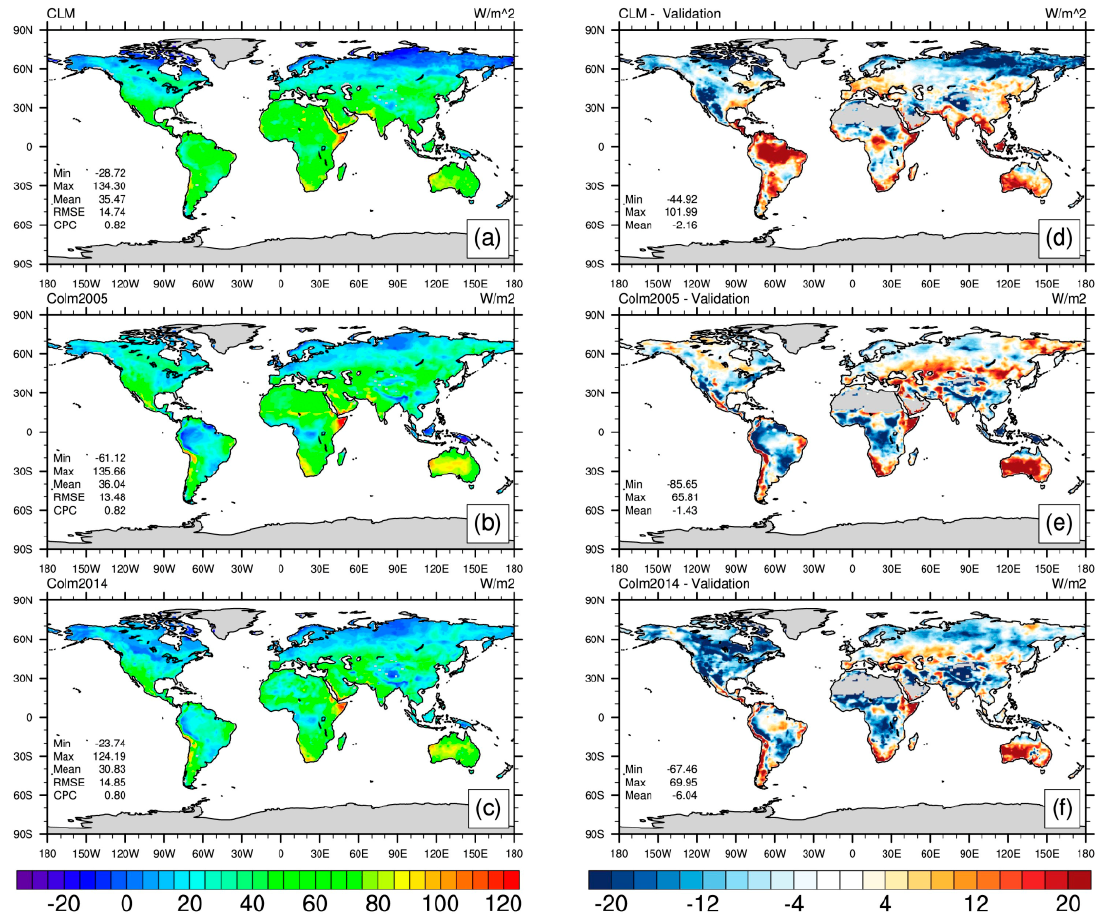
Figure 12. Annual mean spatial distributions of sensible heat flux simulated by ( a ) CLM4.5; ( b ) CoLM2005; and ( c ) CoLM2014; Along with spatial distributions of biases relative to the validation standard for ( d ) CLM4.5; ( e ) CoLM2005; and ( f ) CoLM2014 (Units: W m − 2 ).